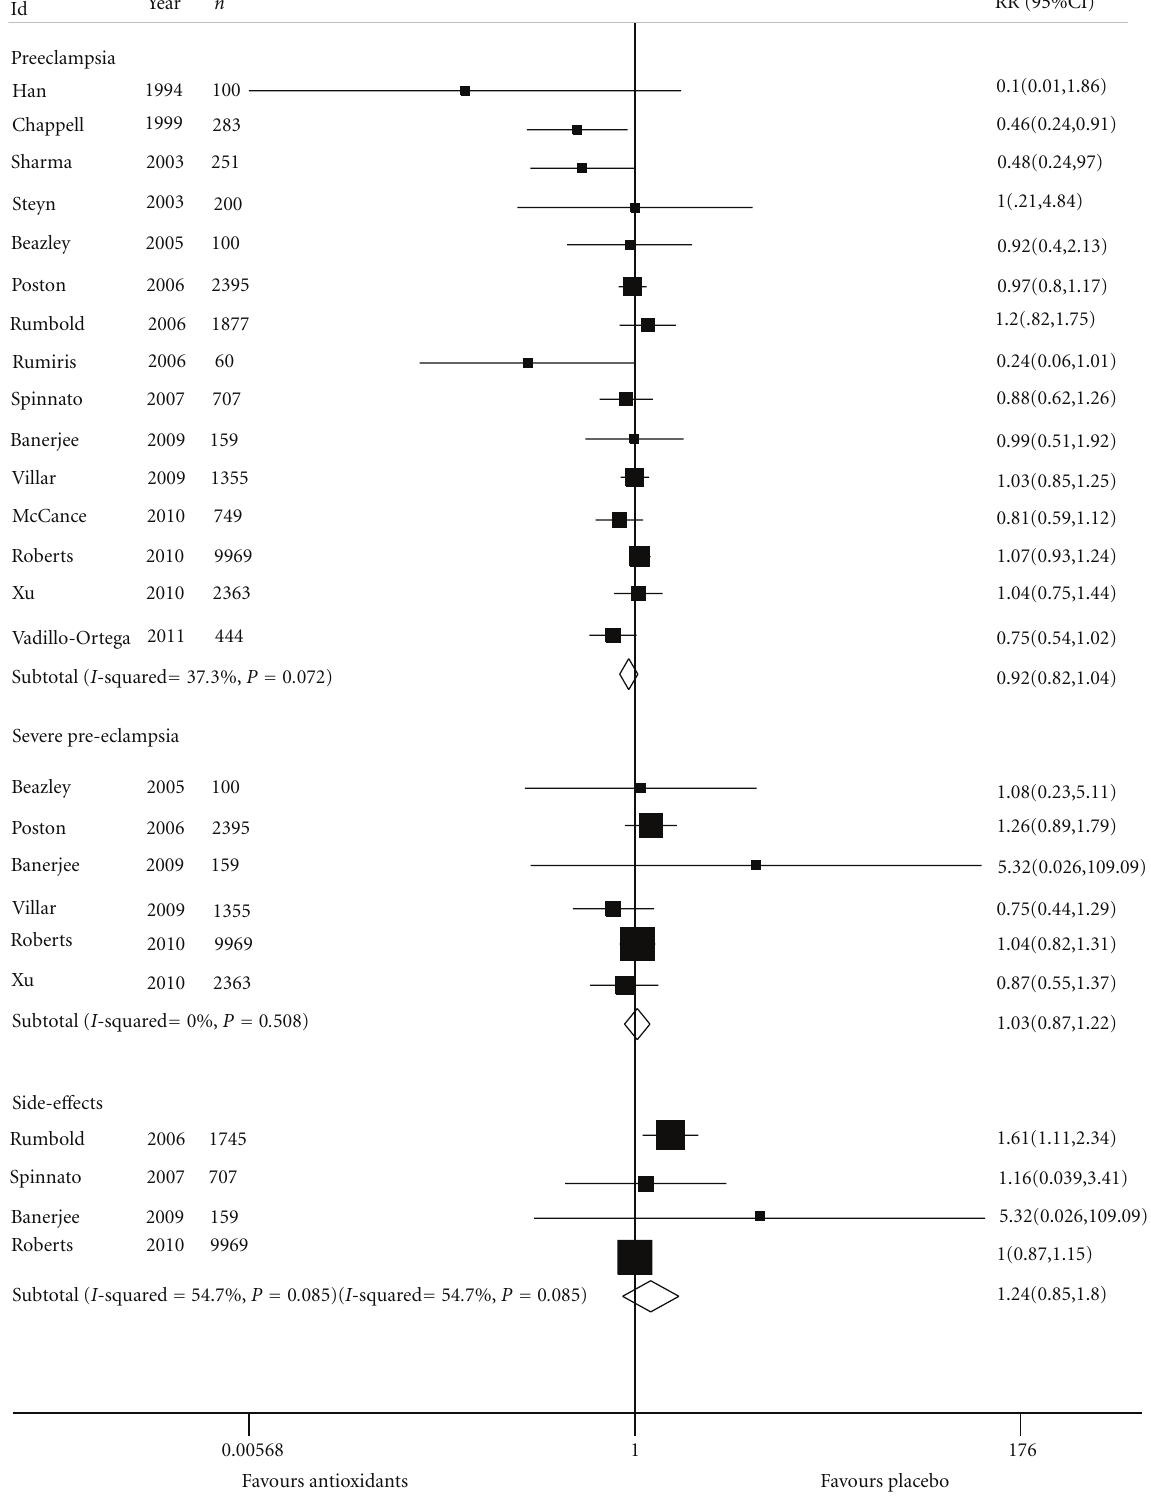
Figure 4: Maternal outcomes. Comparison: antioxidants versus